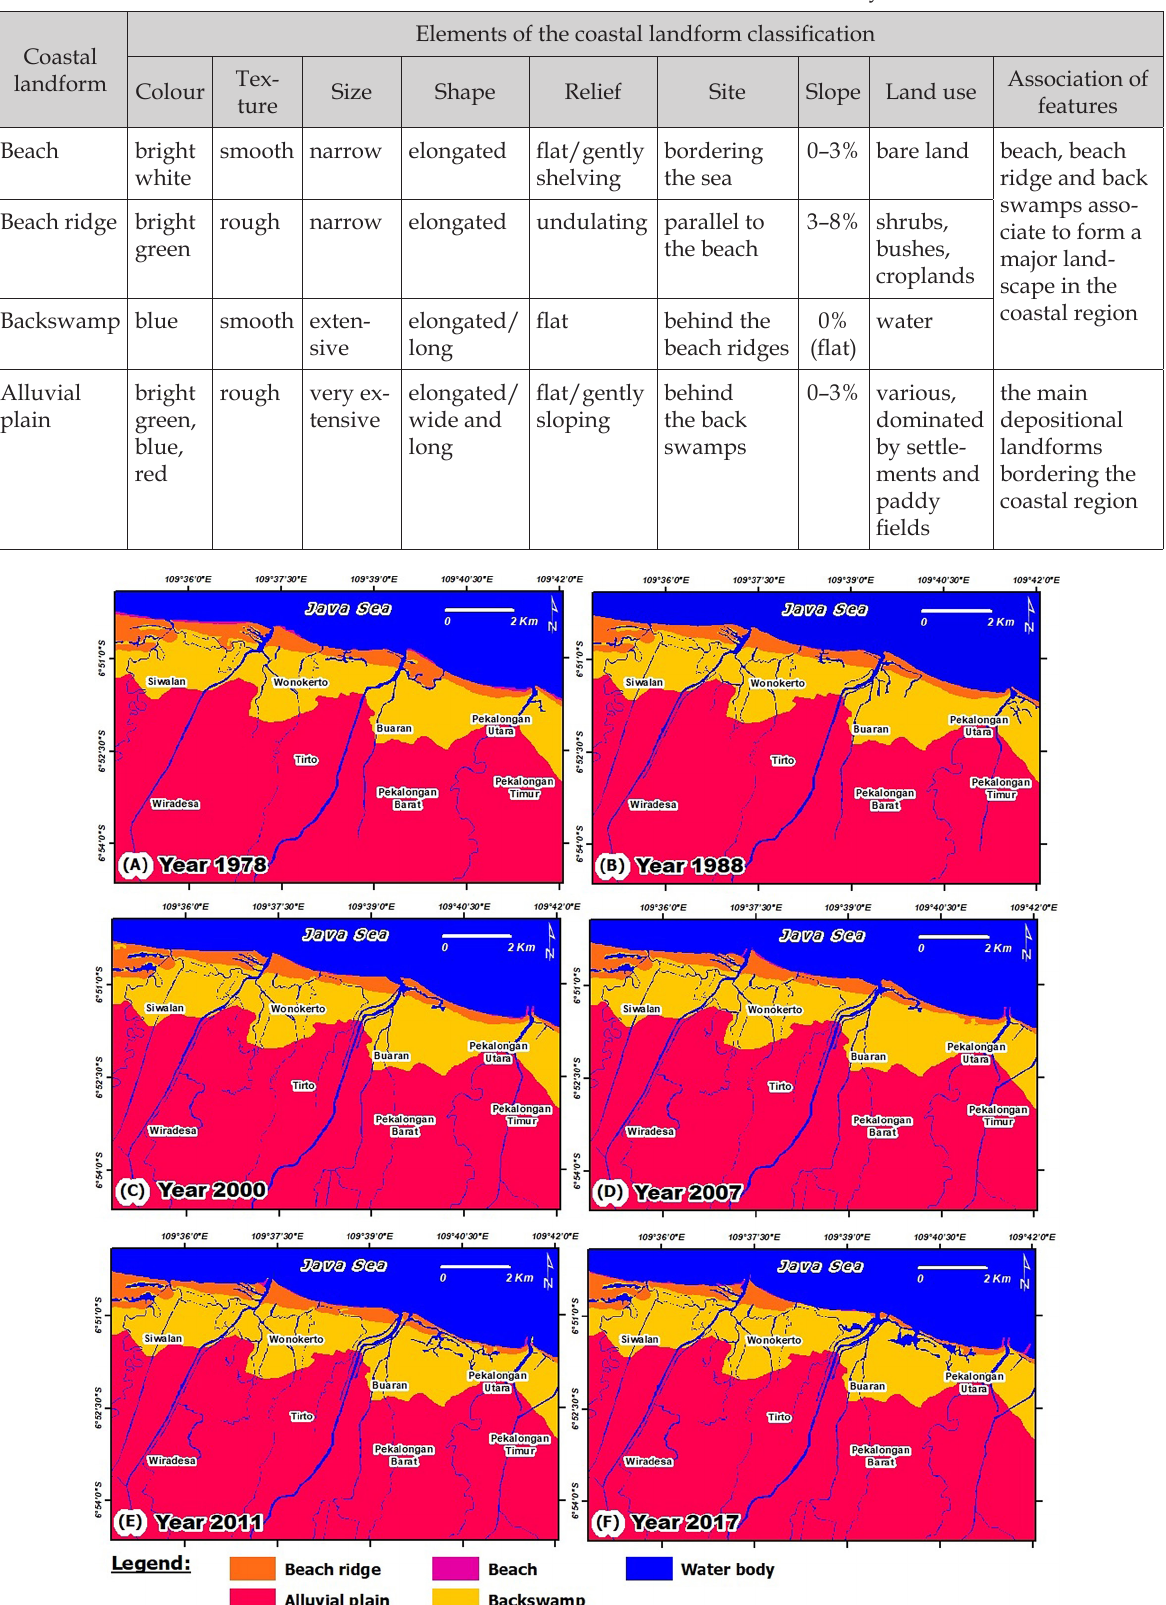
Table 1. Elements of coastal landform classification in the study area.